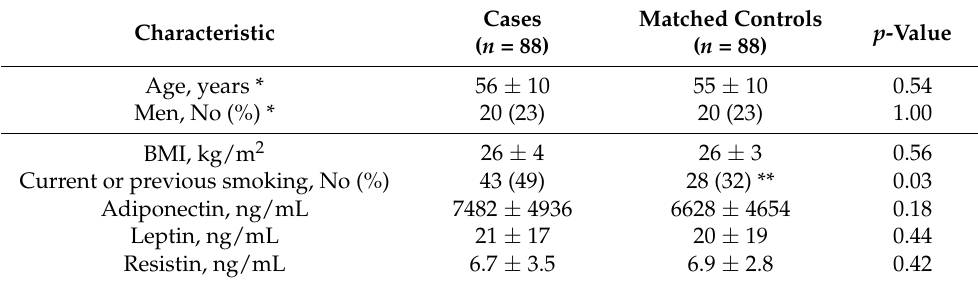
Table 2. Baseline characteristics of the nested case-control cohort from the Medical Biobank of Northern